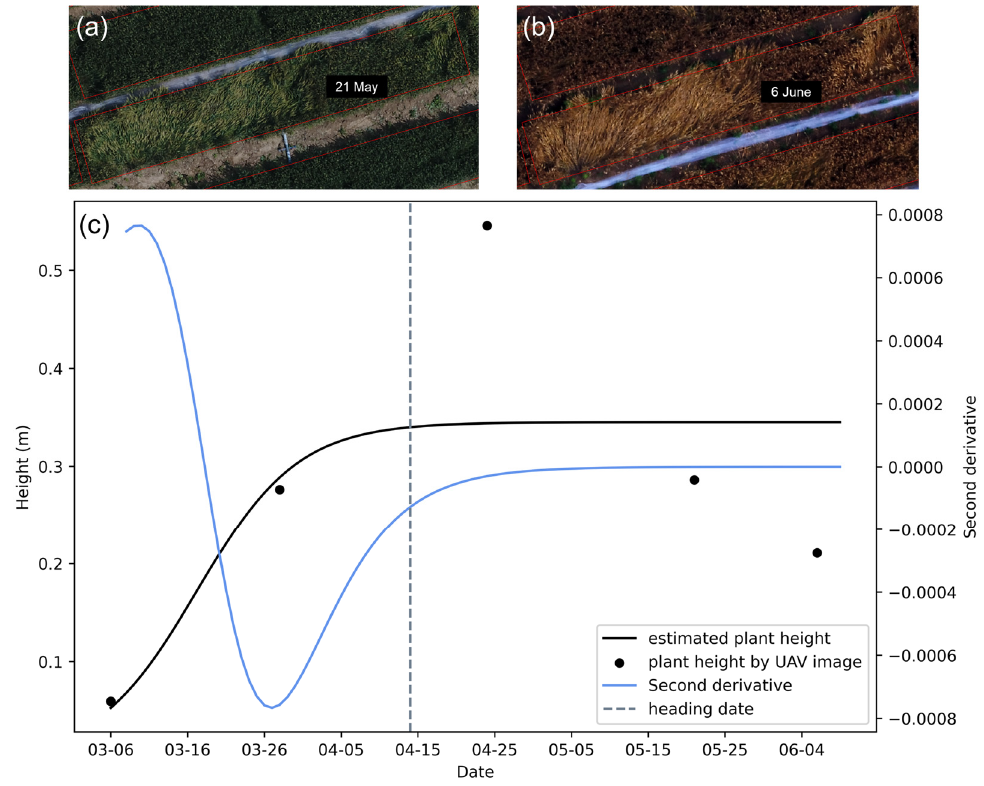
Figure 7. Abnormal data (lodging) for the plot: sowing date: 5 October; variety: Xinong 529; density: 4.5 million plants/ha. ( a ) The orthomosaic of 21 May, ( b ) the orthomosaic of 6 June, and ( c ) plant height growth curve and second derivative.